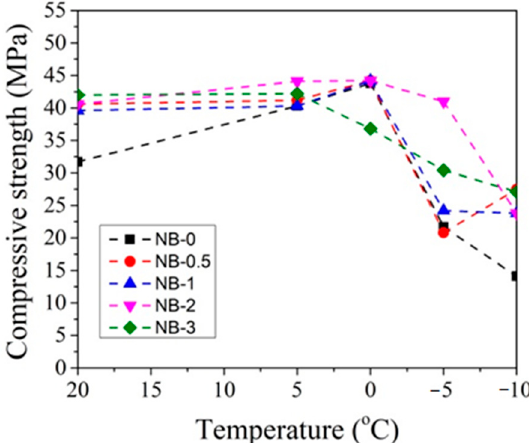
Figure 22. Compressive strength of concrete samples with CEM IIN after 28 days as a function of initial curing temperatures (°C) for CN dosages in the range from 0% to 3%.